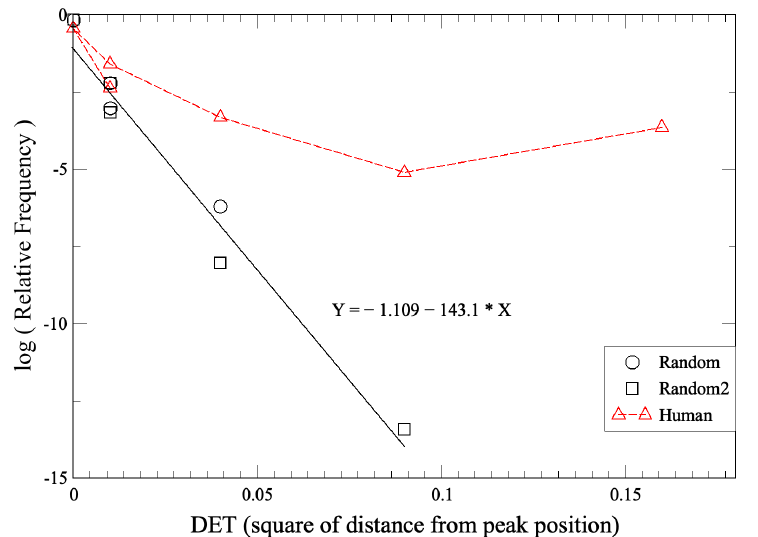
Figure 4. Distribution of relative frequency at different scale. The horizontal axis is the square of distance from the peak value. The results from the pseudorandom series (circle and square black marks) follow a normal distribution. The data are the same as those of Figure